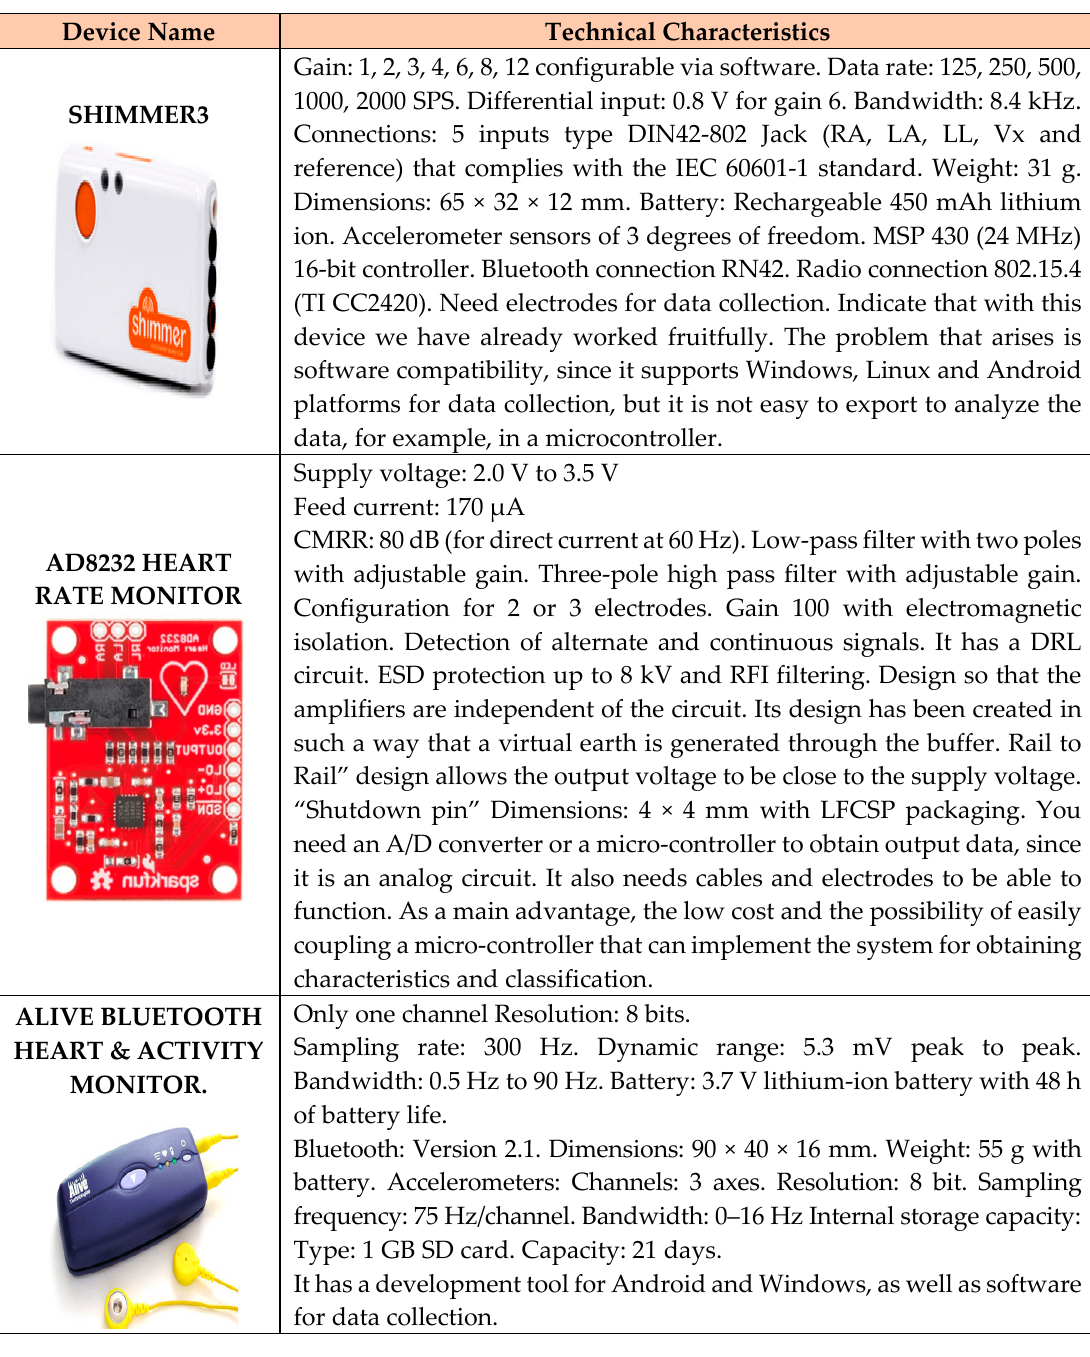
Table 1. Description of three devices for the implementation of the intelligent